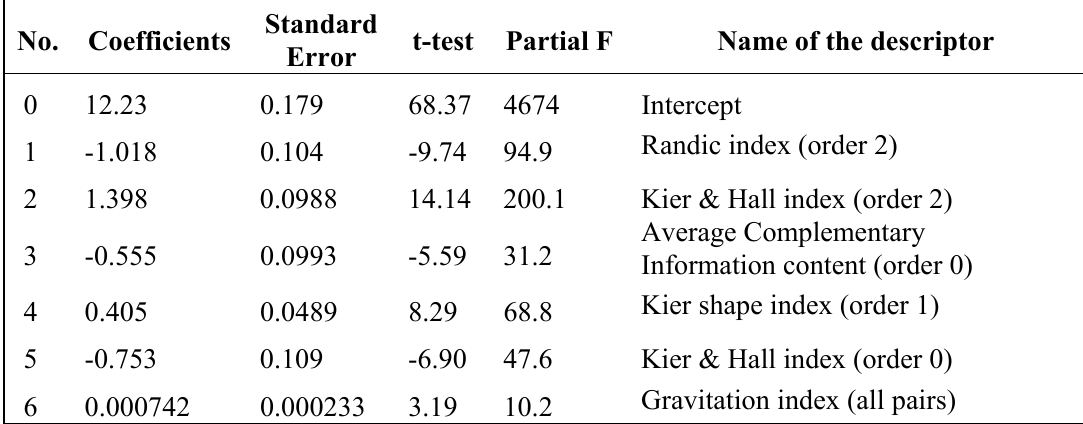
Table 3. Structural descriptors for the best MLR model r 2 = 0.878, F = 55.02, RMS = 0.115